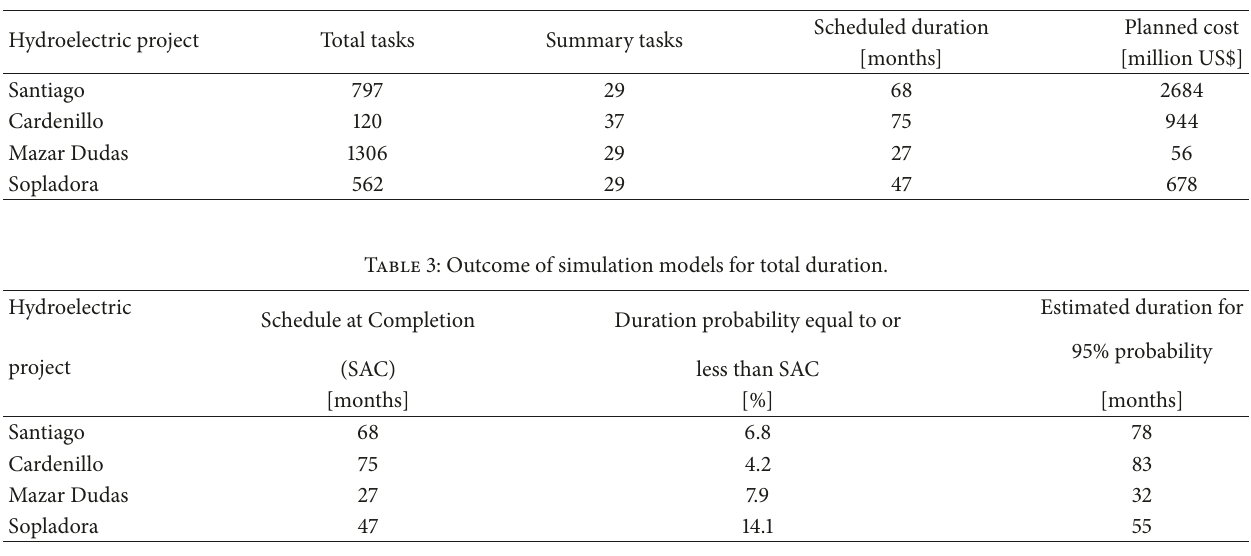
Table 2: Characteristics of the schedules for the projects under analysis.